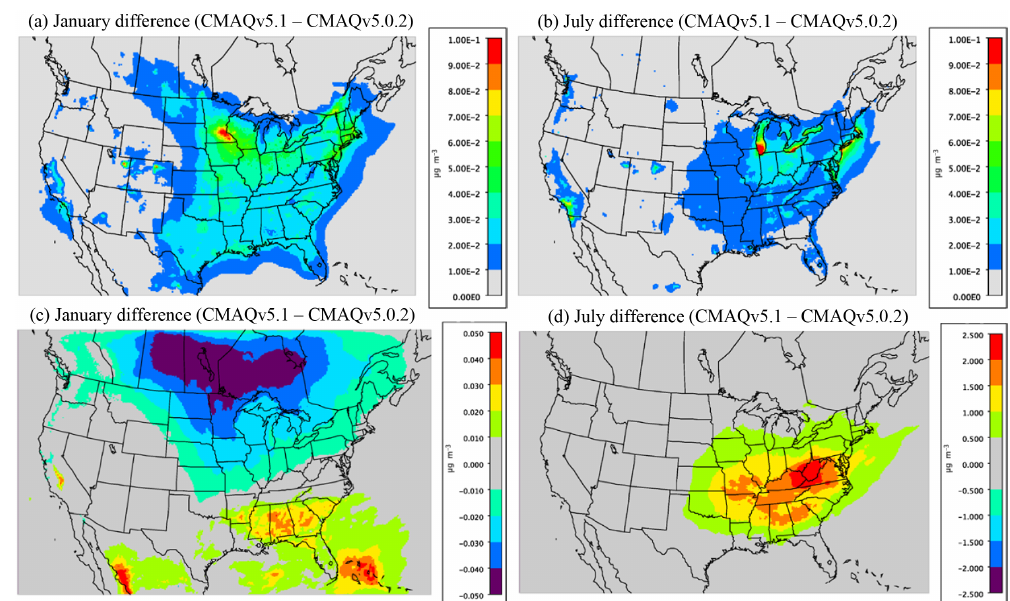
Figure 2. Monthly average sum total of AALK1, AALK2, APAH1, APAH2 and APAH3 for (a) January and (b) July (upper right) and the monthly average difference is the sum total of AISO1, AISO2, AISO3 and AOLGB for (c) January and (d) July between the aerosol treatments in CMAQ v5.0.2 and v5.1 (v5.1–v5.0.2). All plots are in units of micrograms per cubic meter (µgm − 3 ). Note that the scales between each plot may